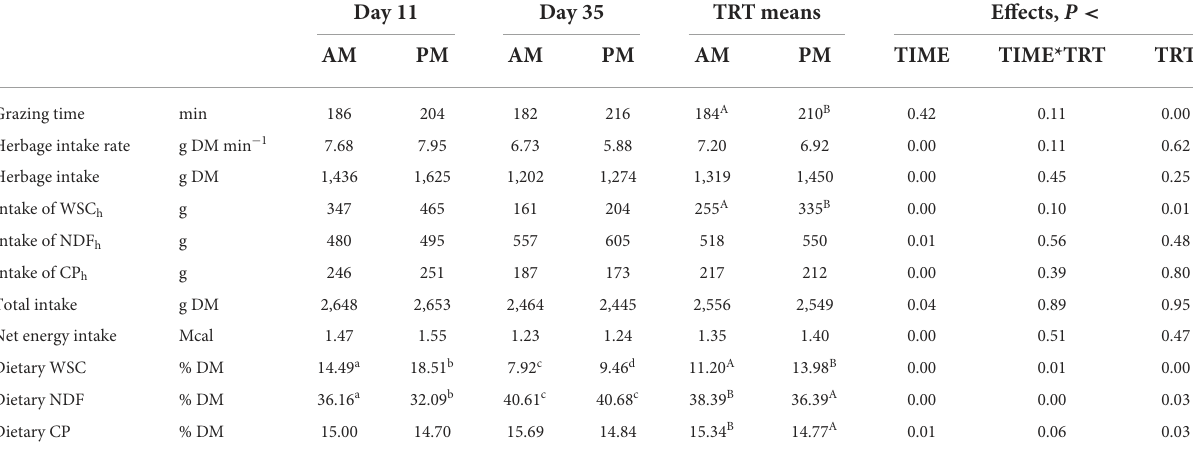
TABLE 1 Effect of the timing of pasture allocation on feeding behavior and intake of herbage, nutrients from herbage (subscript h), total intake and diet composition on 2 test days (day 11 and day 35). Day 11 Day 35 TRT means Effects, P < AM PM AM PM AM PM TIME